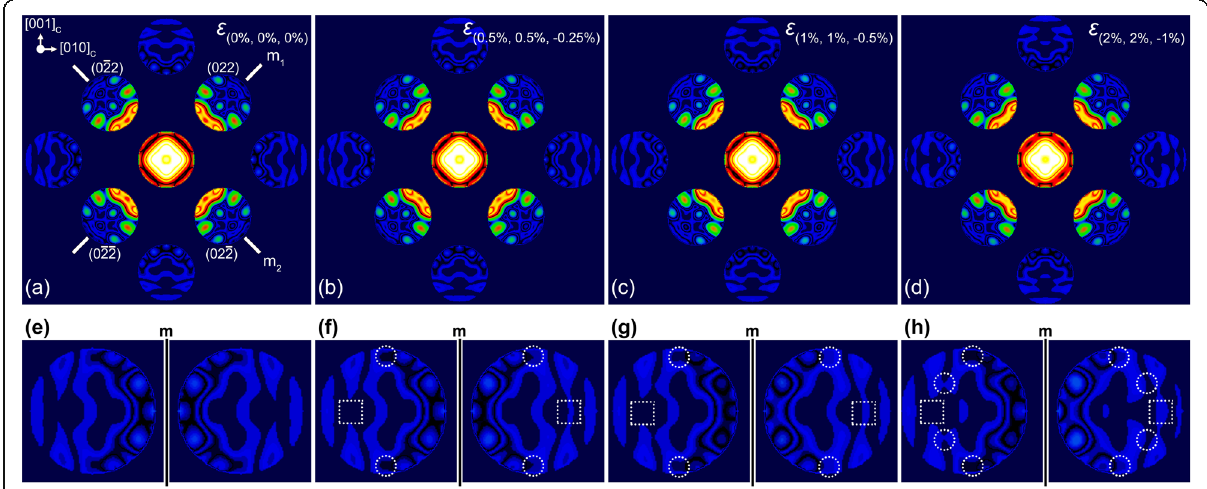
Fig. 1 Calculated CBED patterns for the perfect Si struct. and ( b - d ) the strained Si structures at the zone axis of [100] C . The amount of strain is denoted in each simulated CBED